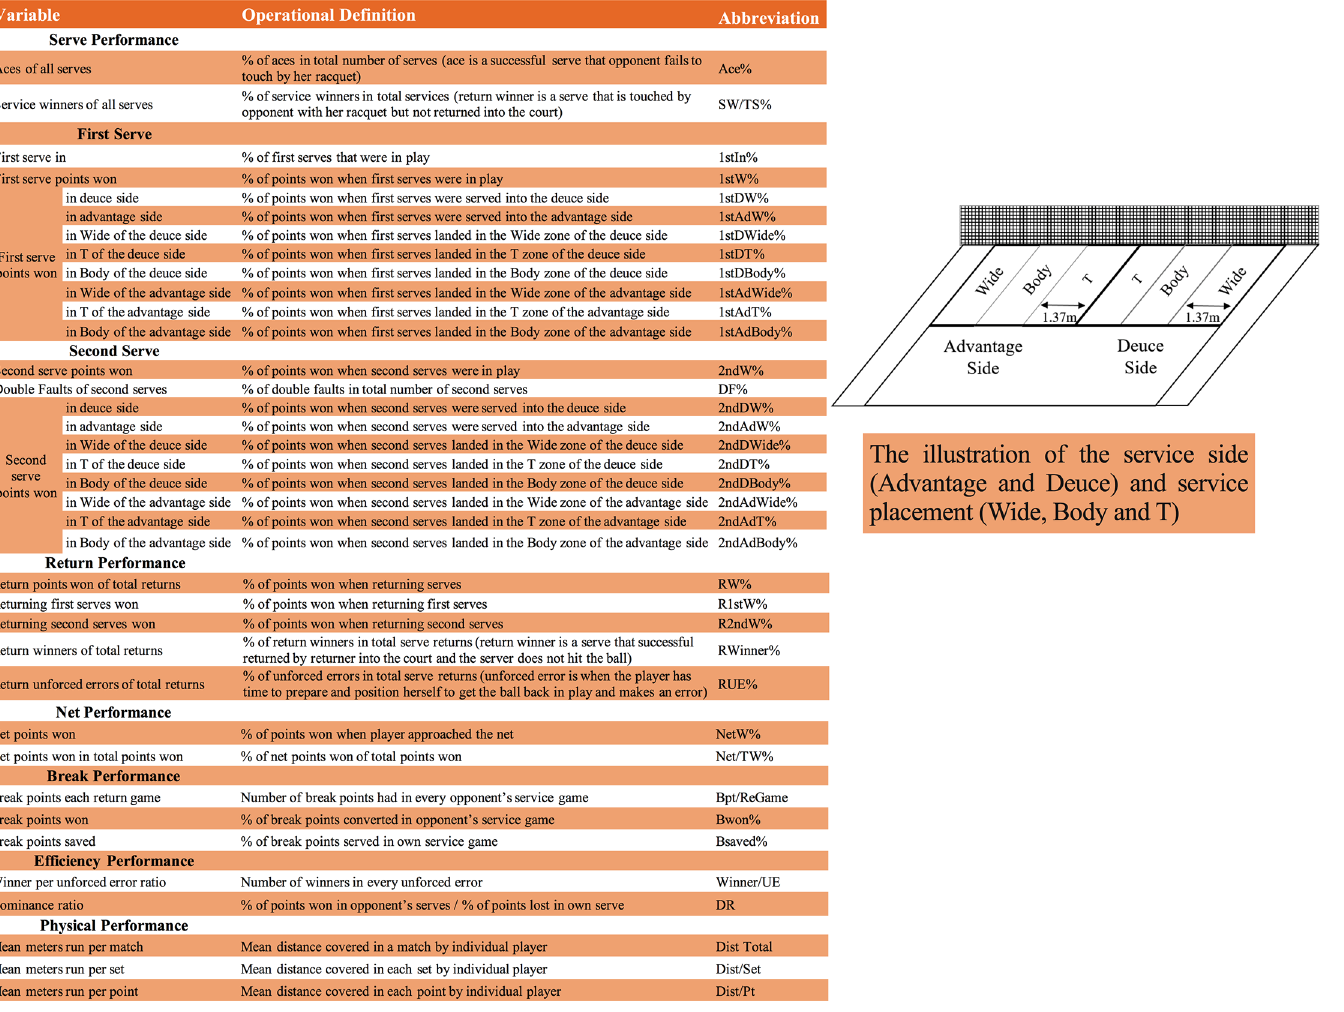
0.90, while the intra-class coefficients (ICC) ranged from 0.96 to 1 and standardized typical errors varied from 0.02 to 0.11, demonstrating high inter-rater reliability [27, 28].